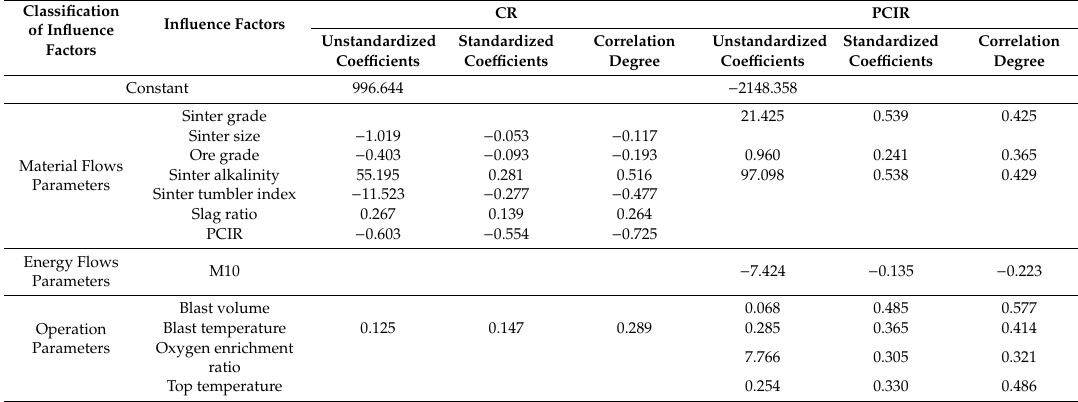
Table 2. Multivariate linear model (MLR) modelson CR and